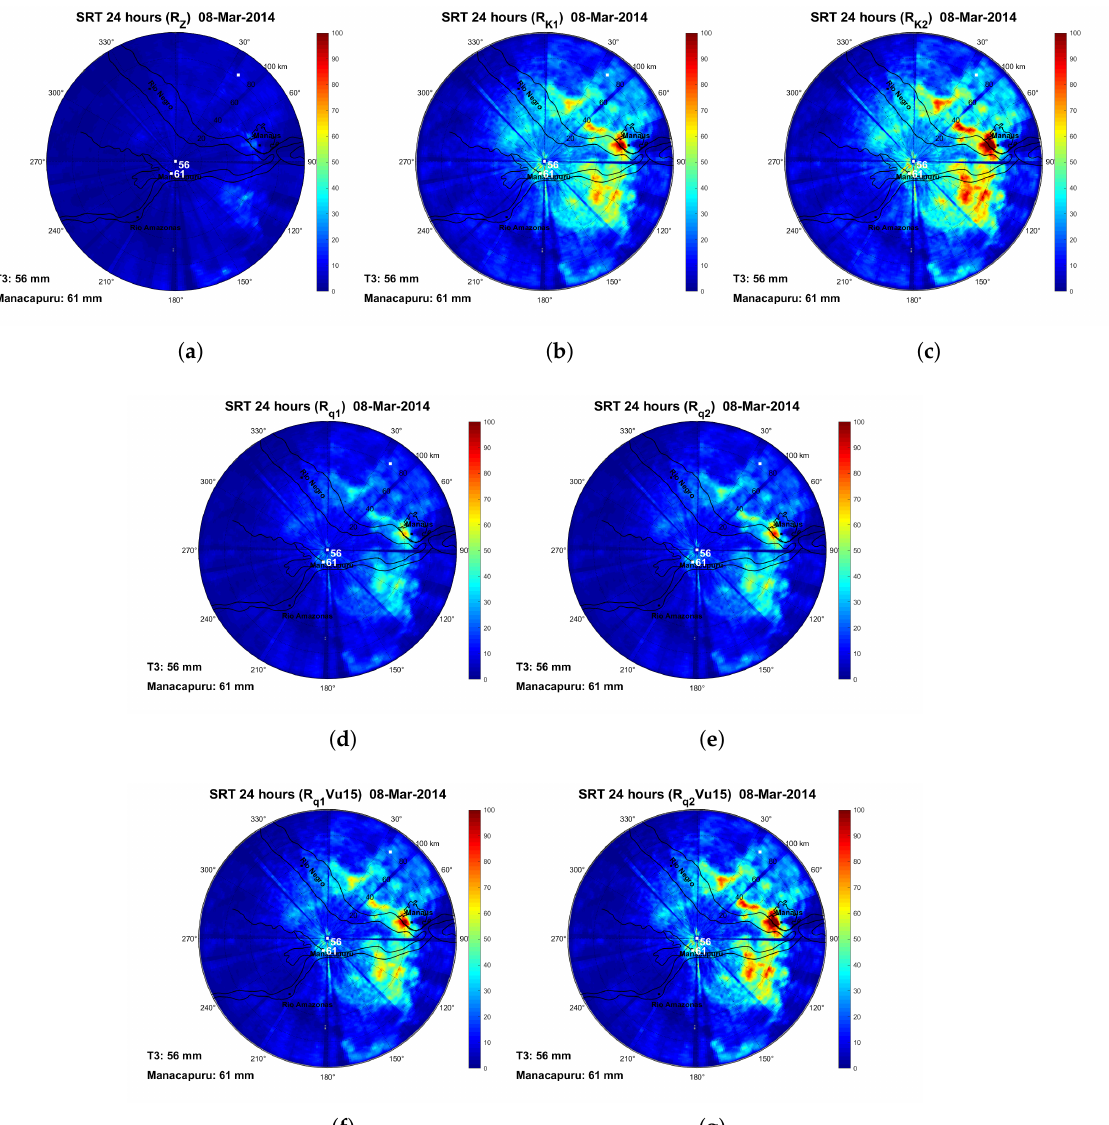
Figure 9. Surface Rainfall Total (SRT) 24 hourly accumulated using ( a ) R Z model, ( b ) R K 1 model, ( c ) R K 2 model, ( d ) R q 1 model, ( e ) R q 2 model, ( f ) R q 1 Vu 15 model and ( g ) R q 2 Vu 15 model for the event which occurred on 8 March 2014. The corresponding values accumulated by the rain gauges are shown in the